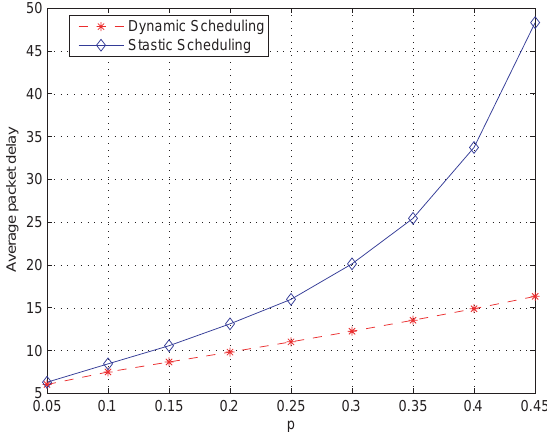
Figure 6. Average Packet Delay vs. p ( ∆ = 1 . 2 , M = 8